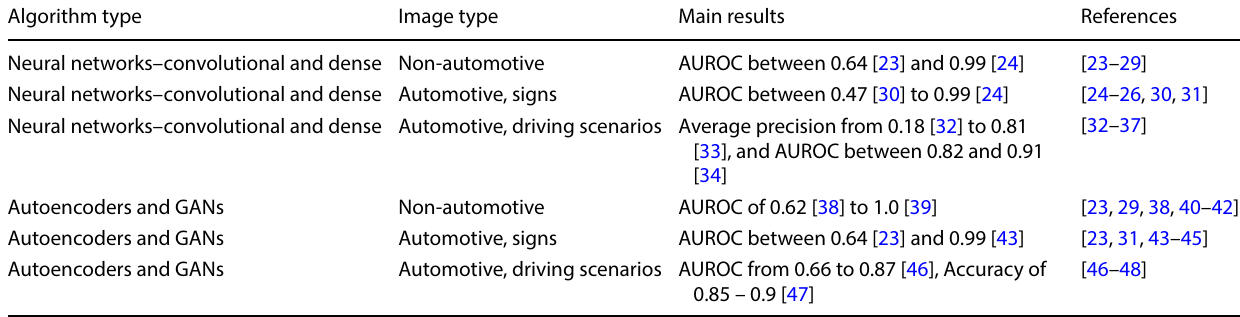
Table 1 Summary of results in anomaly detection on images.